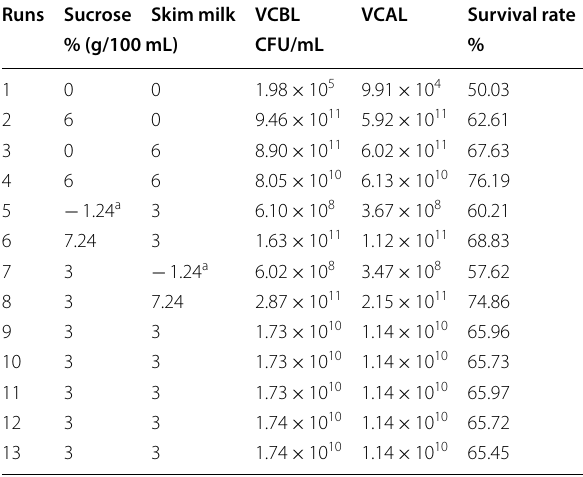
Table 2 Survival rates of L. acidophilus before and after lyophilization in 13 different